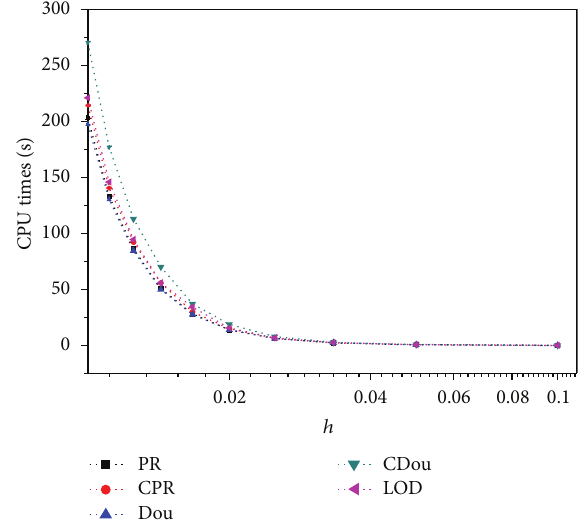
Figure 2: The CPU time of all schemes for various grid sizes when Δ𝑡 = ℎ 2